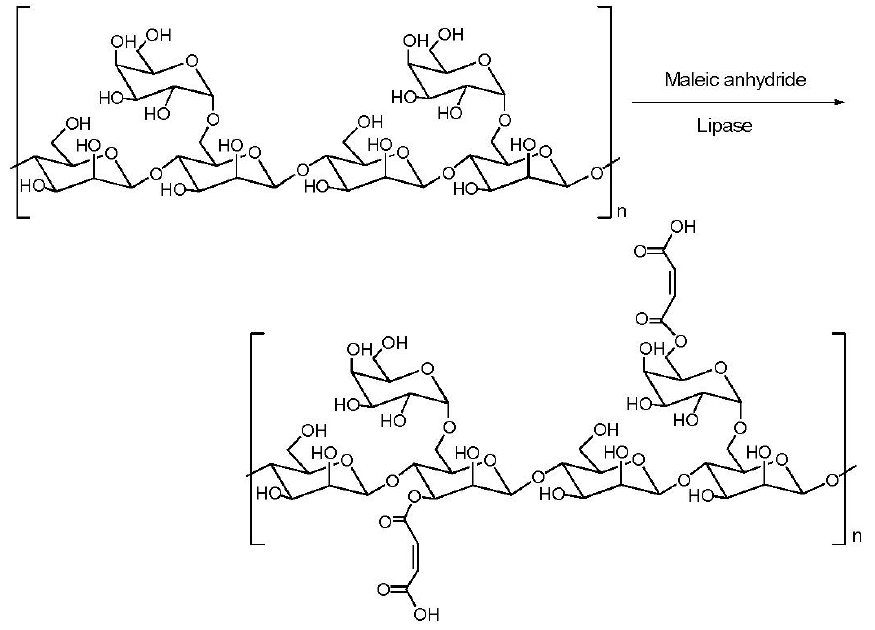
Figure 13. Synthesis of maleated